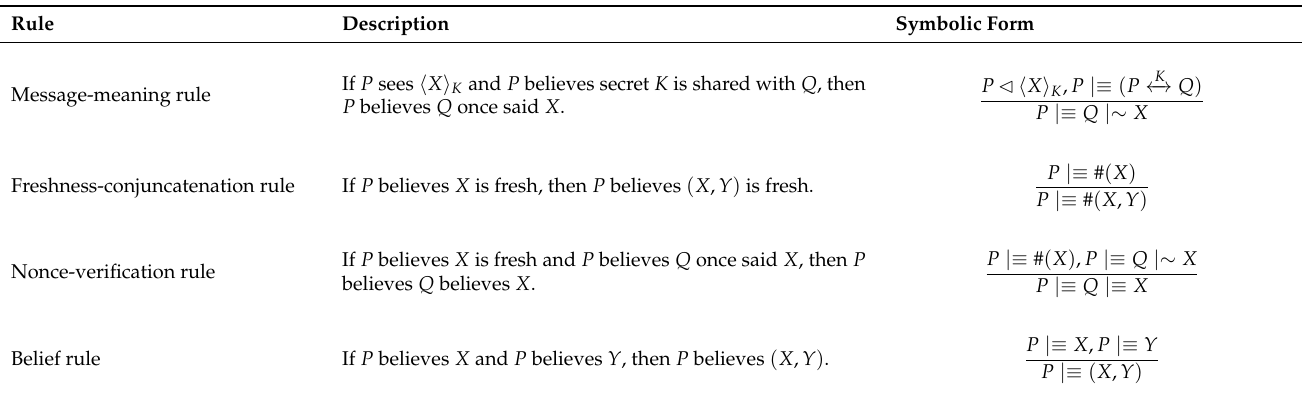
Table 3. BAN logic rules, descriptions, and symbolic